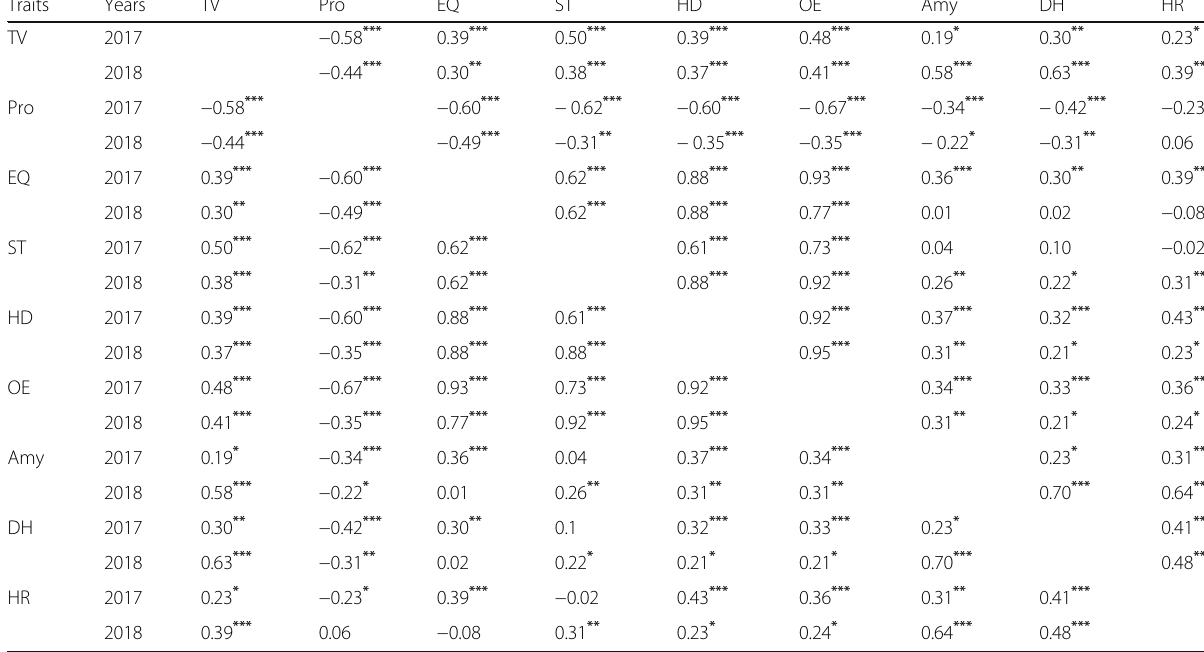
Table 3 Correlation coefficients among traits associated with eating quality in 174 RILs for 2017 and 2018